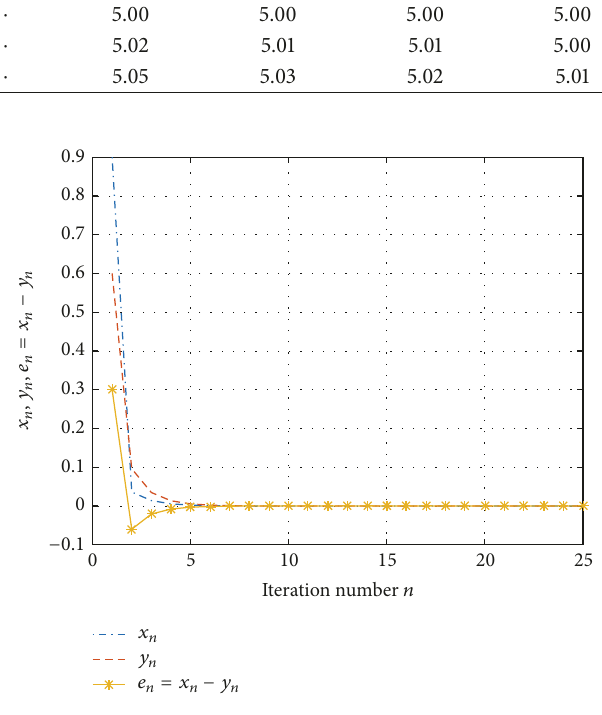
Figure 4: The trajectories of 𝑥 𝑛 , 𝑦 𝑛 , 𝑒 𝑛